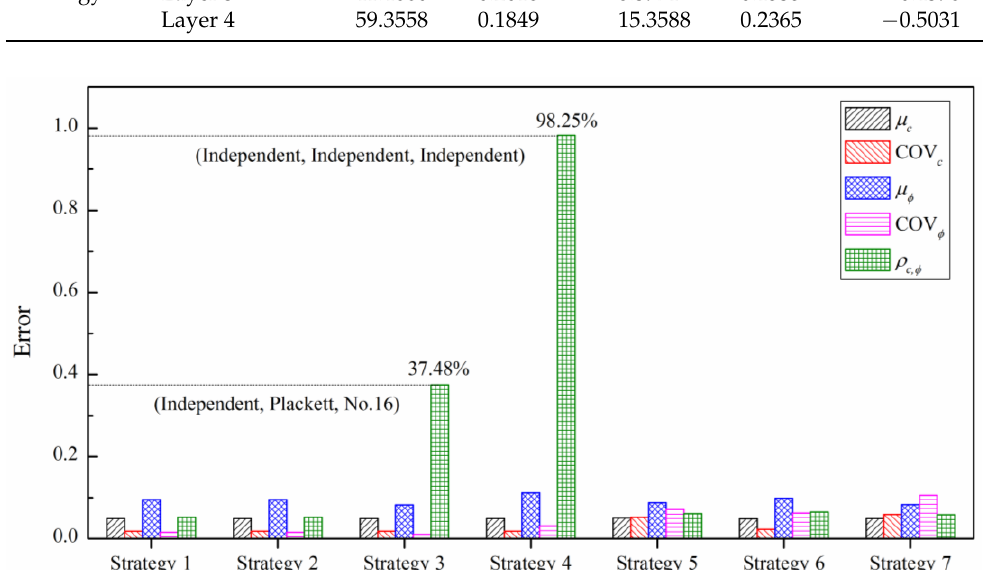
Figure 24. Average errors of the statistics with respect to the three clay layers deduced by different strategies. Table 8. Statistics of CCRF variables associated with different strategies.